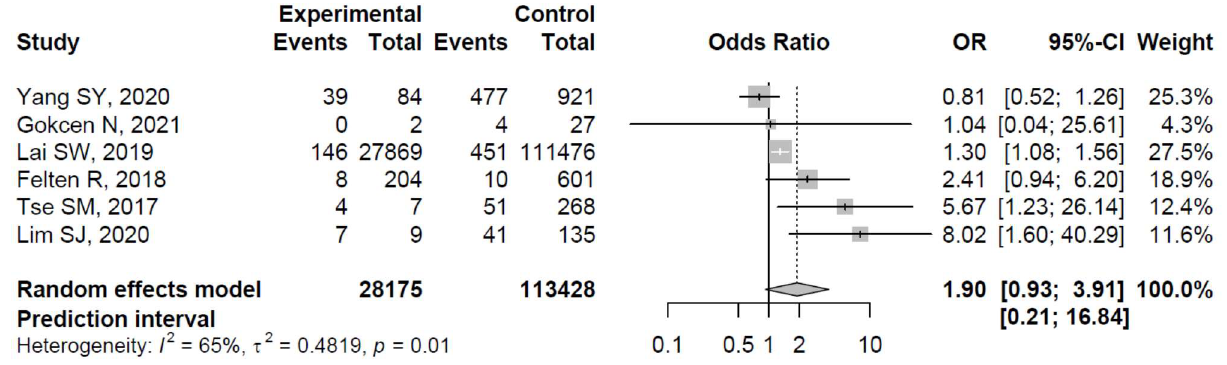
Figure 3. Forest plot showing the association between diabetes and risk of osteonecrosis in sites other